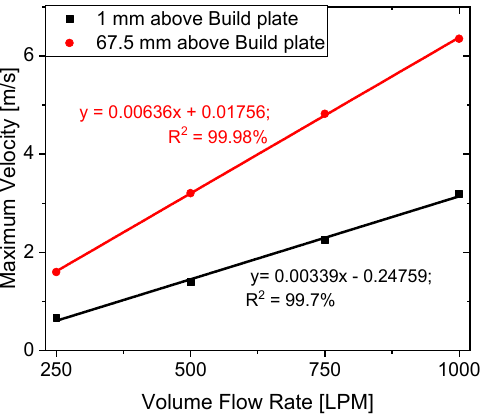
Figure 8. Maximum velocity magnitude as a function of flow rate in the center plane (XZ plane located 67.5 mm above the build plate) and another XZ plane located 1 mm above the build plate.